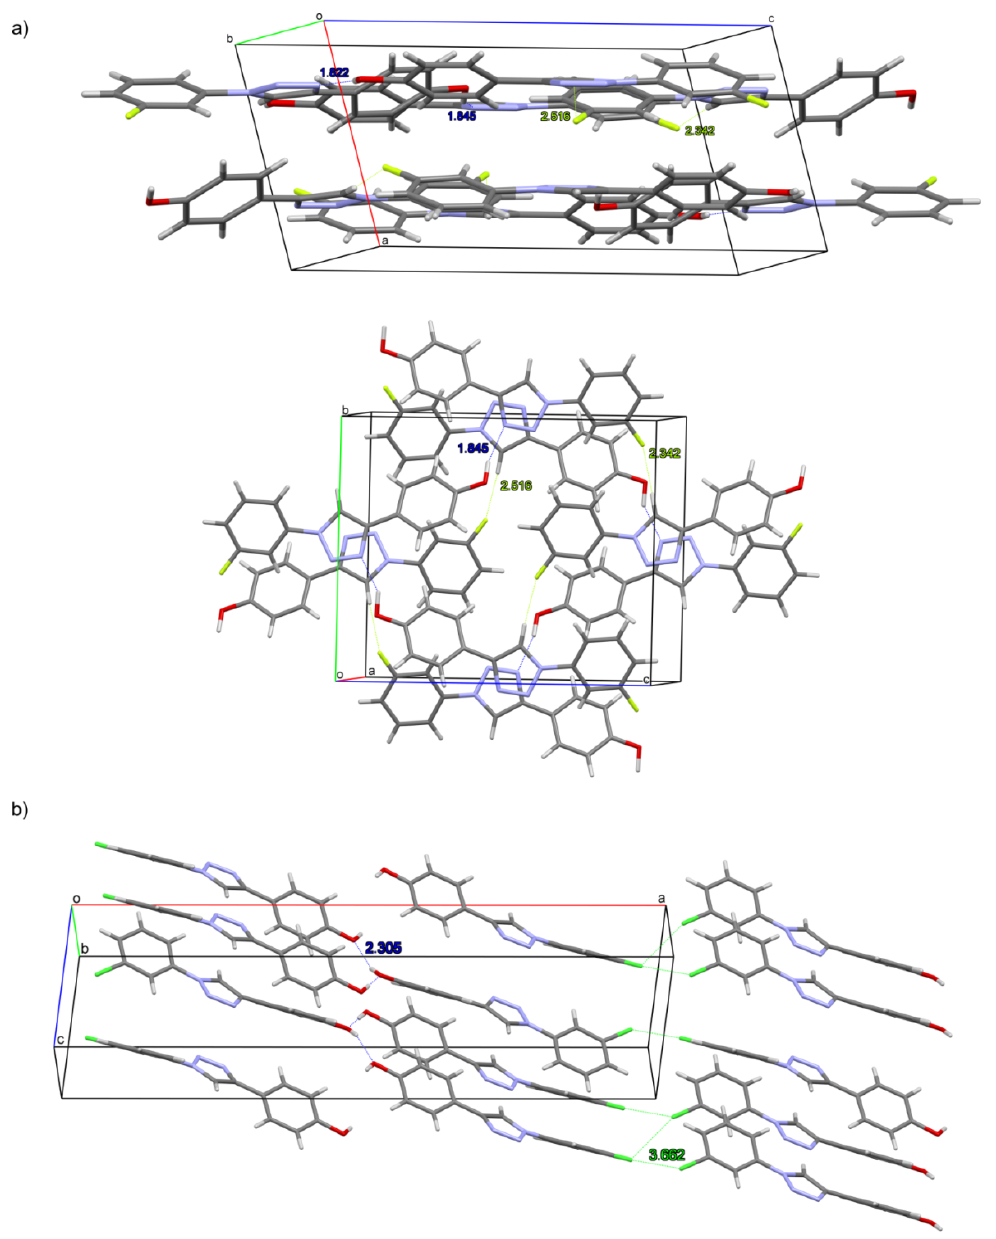
Figure 3. Crystal packings and intermolecular interactions in ( a ) 6a ; ( b ) 6d .